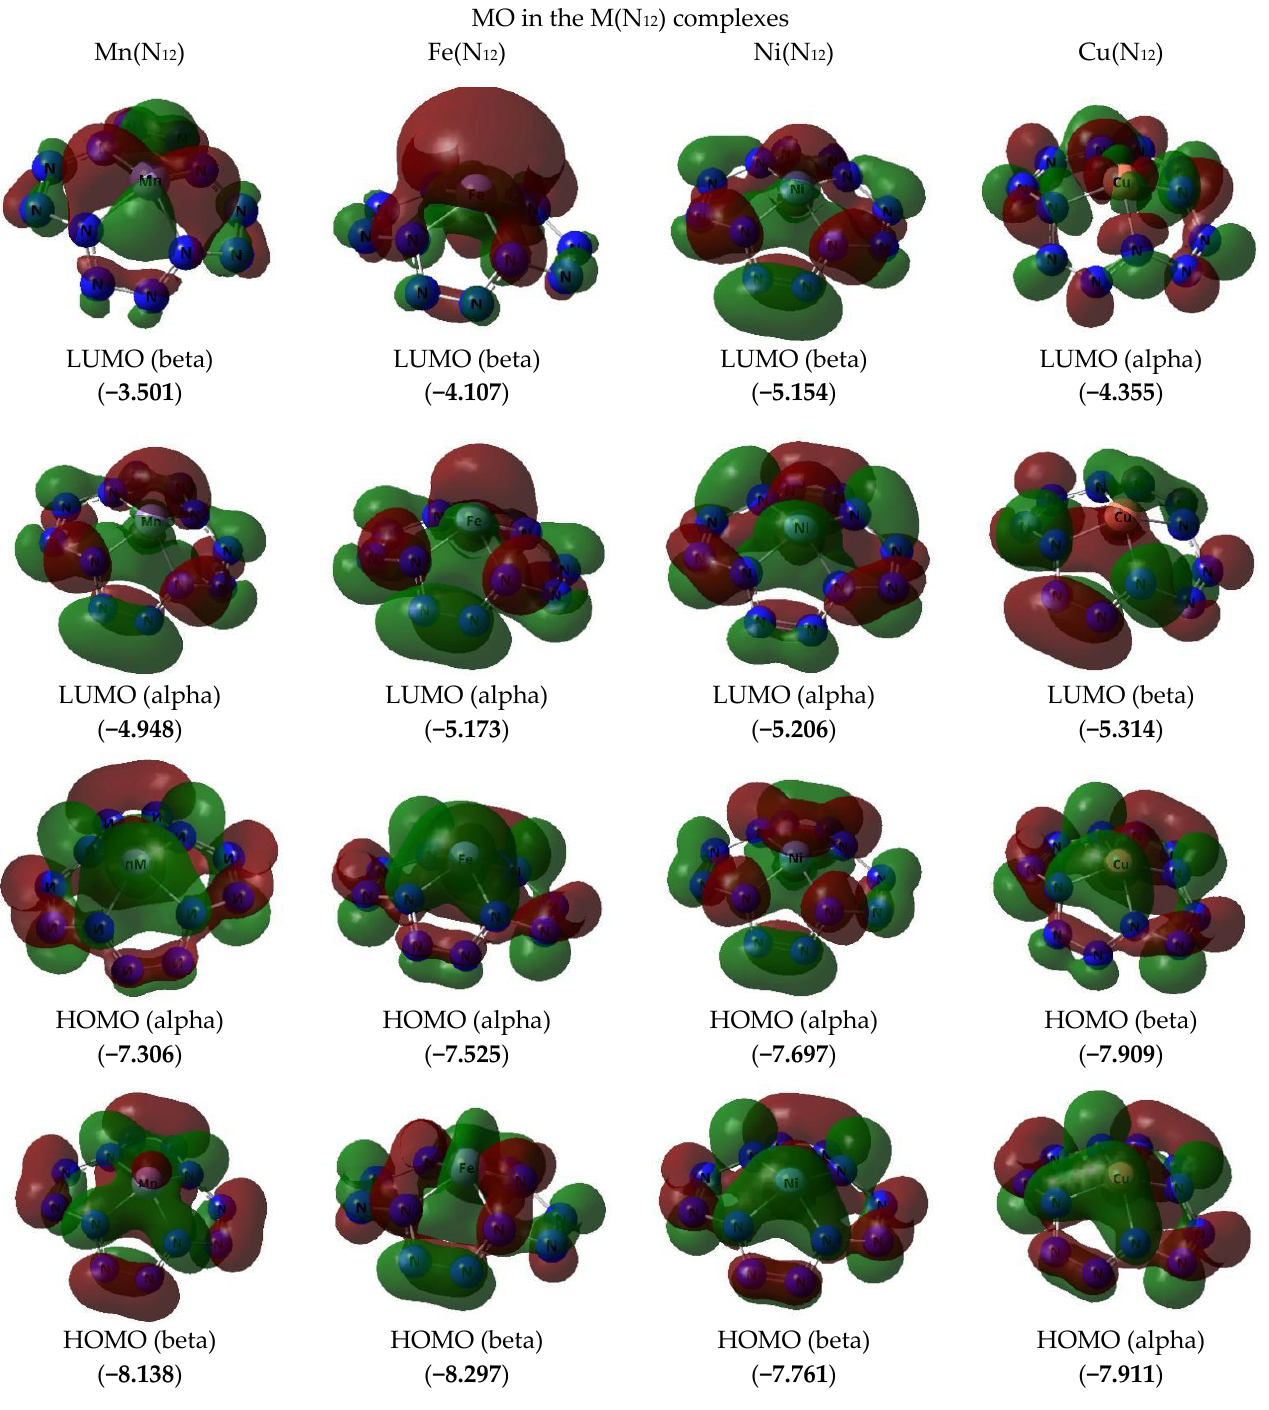
Figure 3. The images of highest occupied (HOMO) and lowest unoccupied (LUMO) molecular orbitals in the M(N 12 )] complex of group B obtained by DFT M06/TZVP method. The values of energies of these molecular orbitals (in brackets) are given in eV. The symbol “alpha” corresponds to electron with spin (+1/2), “beta”, to electron with spin (−l/2).